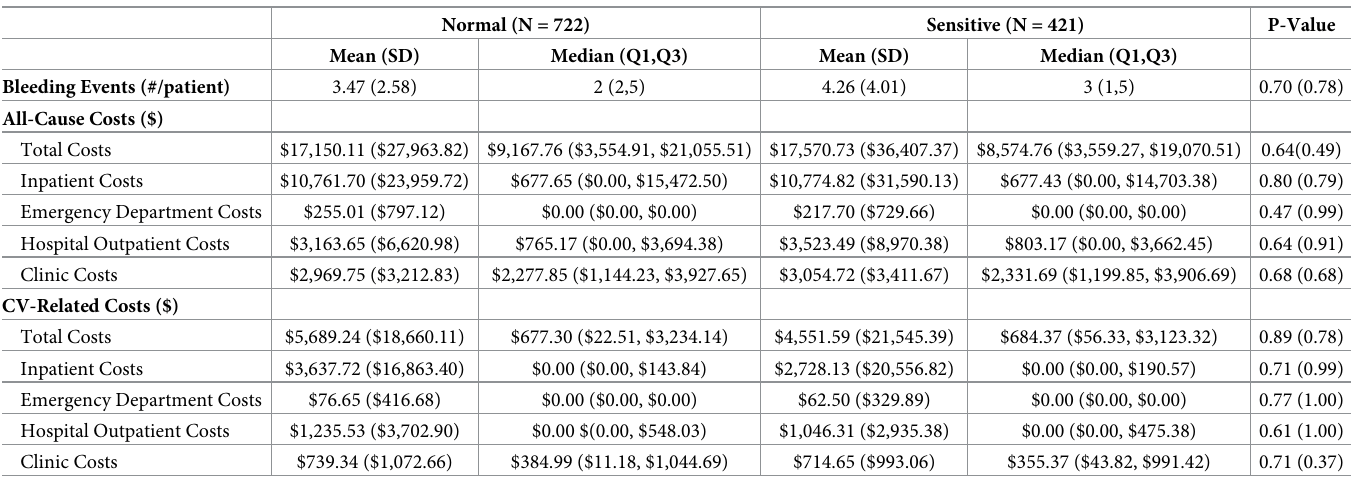
Table 3. Summary of crude outcomes across exposure